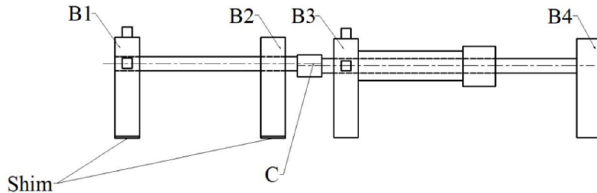
Fig. 3. The schematic diagram of parallel misalignment of coupling.